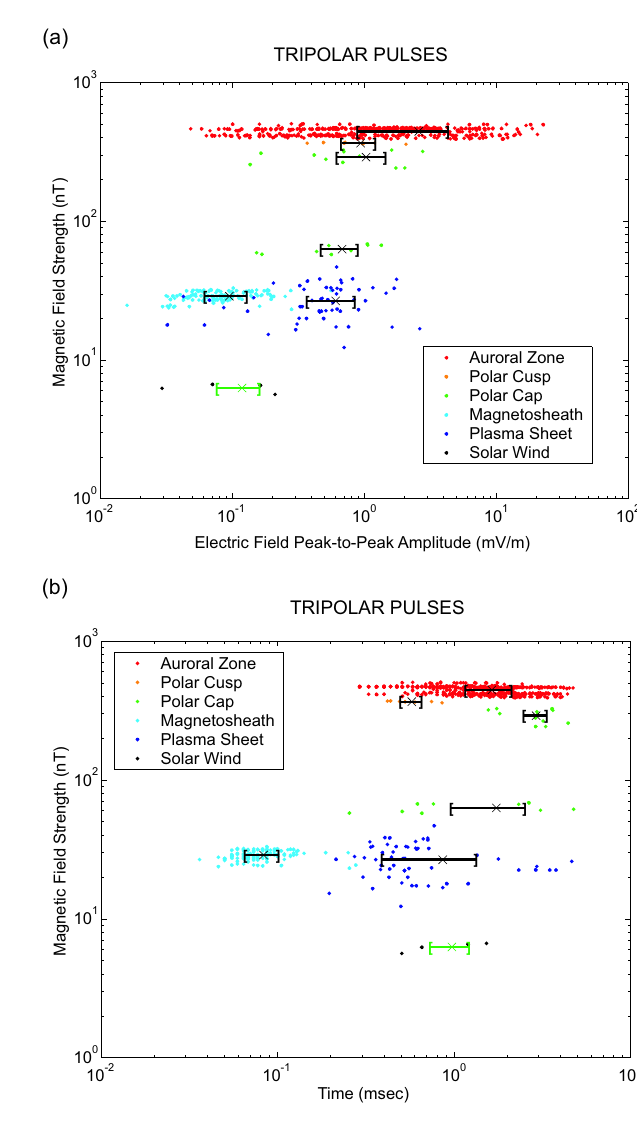
Fig. 3. Survey of the bipolar pulses observed by Cluster WBD over a two-year period. ( a ) Electric field amplitude vs. magnetic field strength showing a trend of increasing electric field amplitude with increasing magnetic field strength. The over plotted bracketed lines with an imbedded “x” within each regional grouping represent the standard deviation and mean of that group, respectively. ( b ) Pulse duration vs. magnetic field strength showing no trend between the two, but pointing out the obvious difference of the time durations of the magnetosheath pulses to pulses in all other regions. Bracketed lines with the imbedded “x” represent the standard deviation and mean of each regional group.